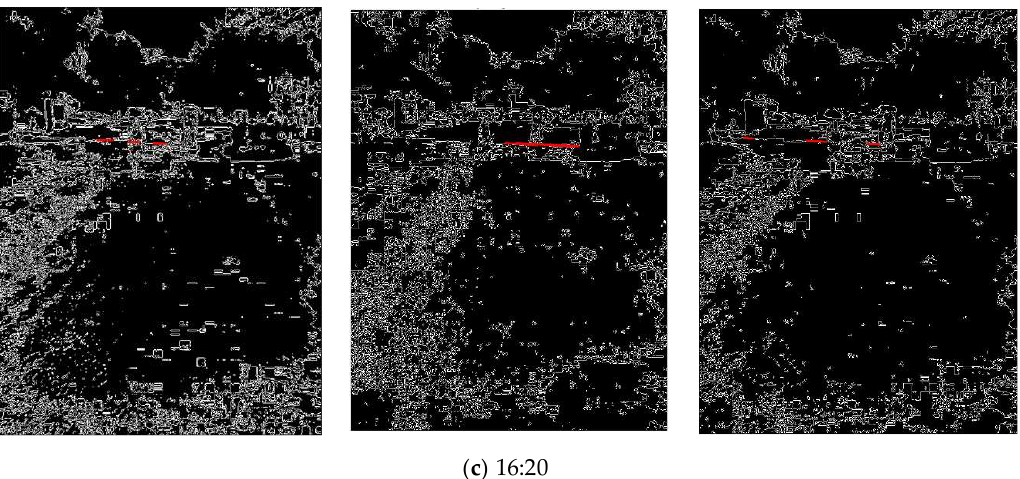
Figure 6. VGI classified images ( upper ) and water line detection ( bottom ). Image-based VGIs were simplified into three classification categories, namely water in blue, vegetation in green, and buildings in black based on the classifications of RF ( left ), ML ( middle ), and SVM (right ). The classified image-based VGIs were processed using HT-Canny to detect water lines (red lines) at the acquisition times of ( a ) 15:20, ( b ) 16:10, and ( c ) 16:20. Table 1. The percentage of Producer’s accuracy, user’s accuracy, F1 score, overall accuracy, and kappa statistic for three classification categories of RF, ML, and SVM